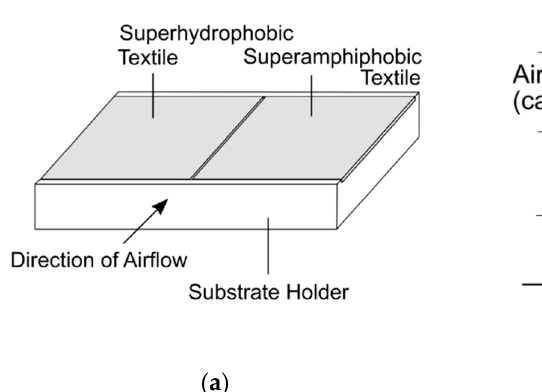
Figure 3. Diagram of the NACA 0012 support with 180 mm-chord length and labels for positions on